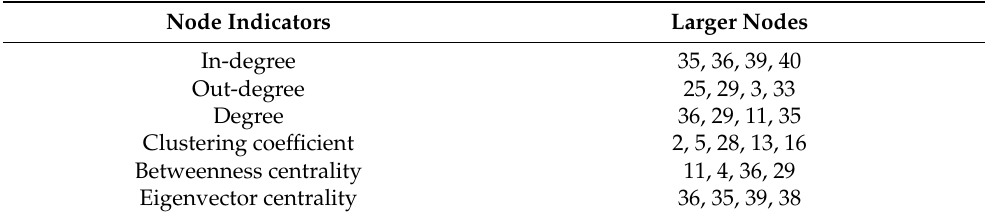
Figure 9. The NQPB of Project A. Through the Gephi calculation, important nodes with larger out-degrees, in-degrees, degrees, clustering coefficients, and eigenvector centralities were derived, respectively, as shown in Table 4. Table 4. Nodes with larger node indicators in the NQPB of Project